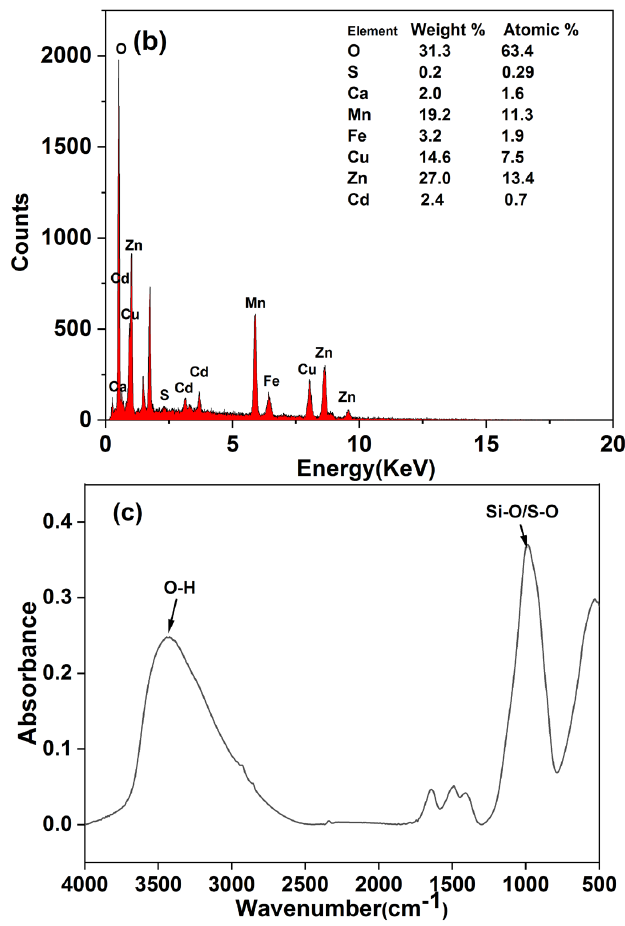
Figure 5. ( a ) XRD, ( b ) EDS and ( c ) FT − IR patterns of precipitates.